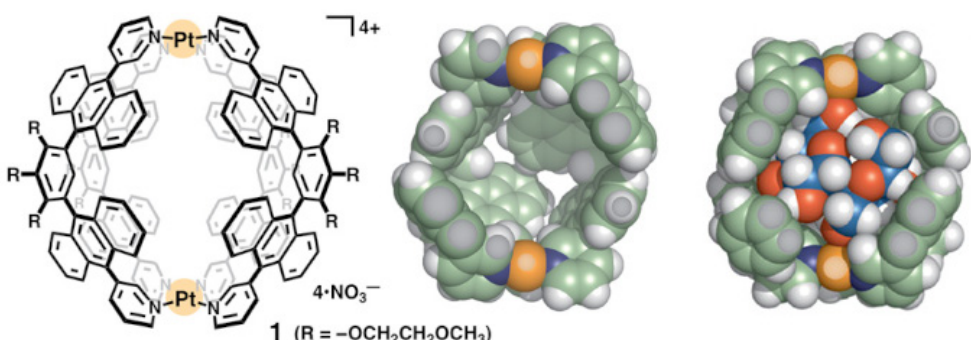
Figure 11. ( Left ) Molecular representation and ( Middle ) its space-filling representation for the nanocapsule based on Pd(II) and anthracene for selective sucrose binding. ( Right ) corresponds to the complex sucrose-nanocapsule in space-filling representation. Substituents and counterions are omitted for clarity. Figure from reference